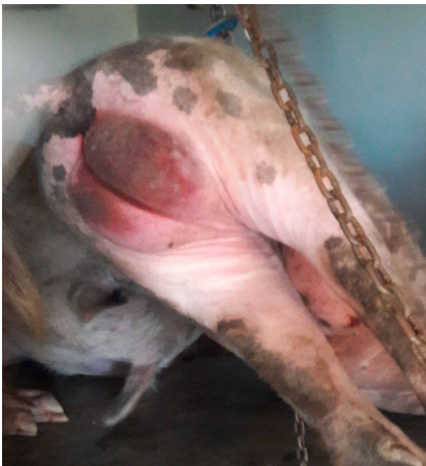
Figure 2: Picture showing hyperemia of the